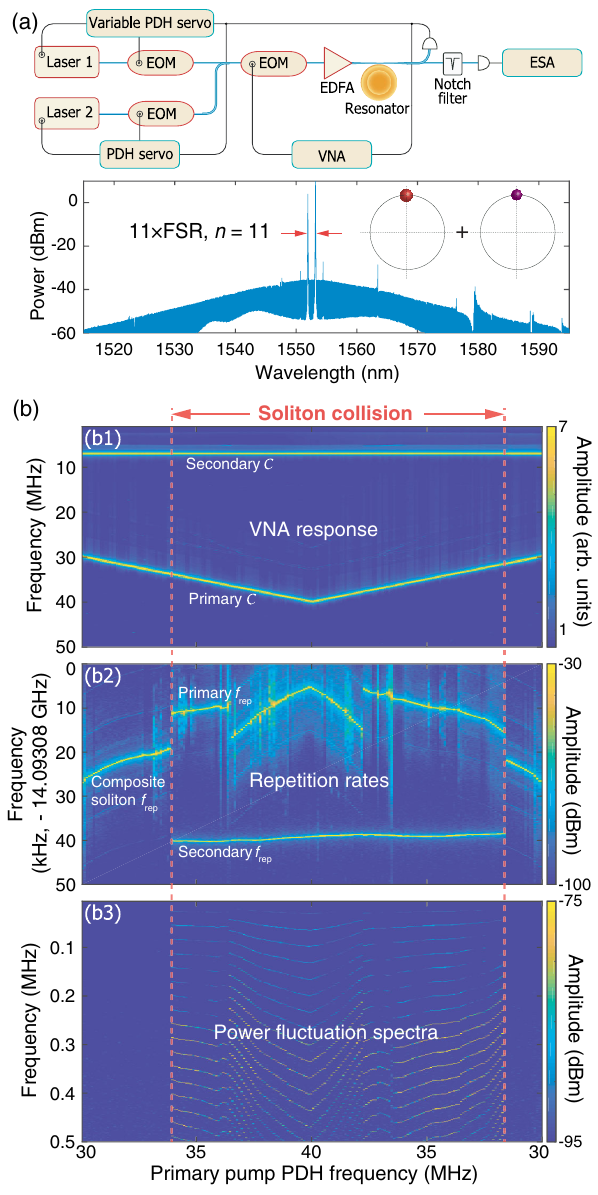
FIG. 6. Reversible switching between composite soliton state and collisional soliton state. (a) In the experimental setup (top), the two lasers are separated from each other by ∼ 11 FSRs, and the two pump-resonance detunings are actively locked by locking the phase-modulated sidebands of lasers to the Pound-Drever-Hall (PDH) error signals. While the secondary pump-resonance detun- ing is unchanged, the detuning of the primary pump is varied by continuously tuning the PDH modulation frequency. The optical spectrum of the coexistence of a primary soliton and a secondary soliton (bottom). (b) The evolutions of the VNA response (b1), the repetition rate spectra (b2), and the power fluctuation spectra (b3) as the primary pump-resonance detuning is varied from 30 to 40 MHz and then back to 30 MHz. The jumps of the primary f around 37 MHz are attributed to a strong single dispersive wave [11] that we confirmbycomparingtheacquiredmicrocomb spectra before and after the jump. The range where the state of soliton collision is switched on is denoted by the red dashed